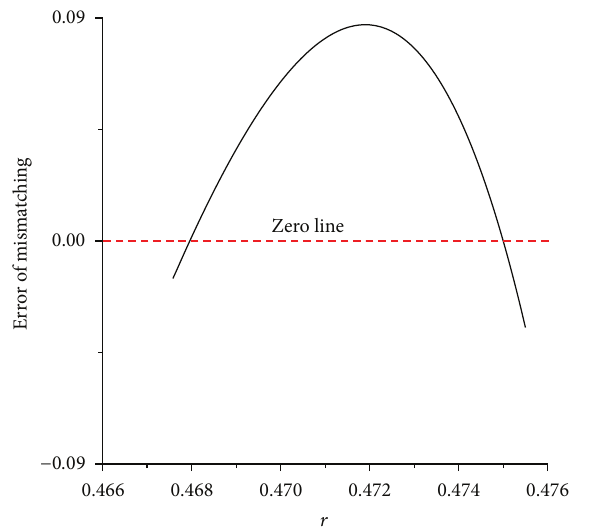
Figure 4: Example 3 solved by the SL (3, R ) method, showing the error of mismatching. There are two roots.